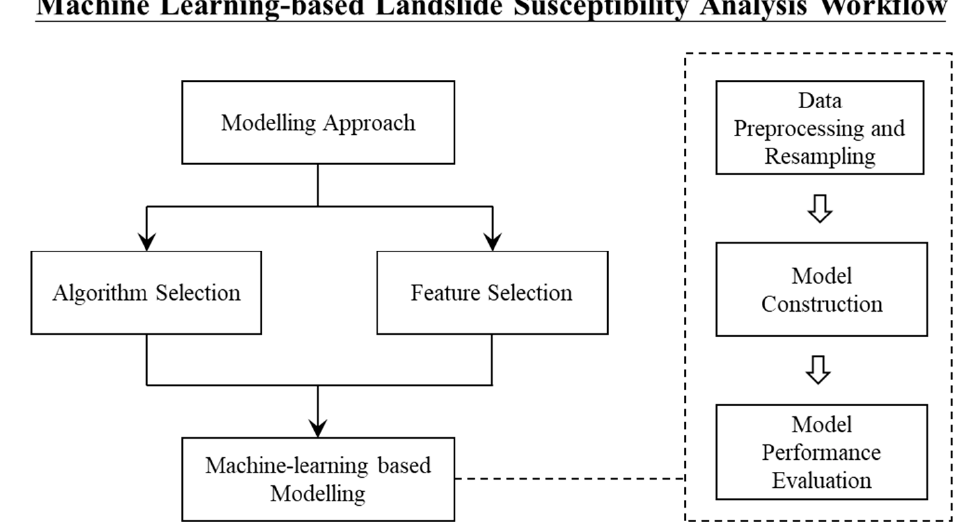
Figure 3. Workflow of the Machine Learning-based Landslide Susceptibility Pilot Study.